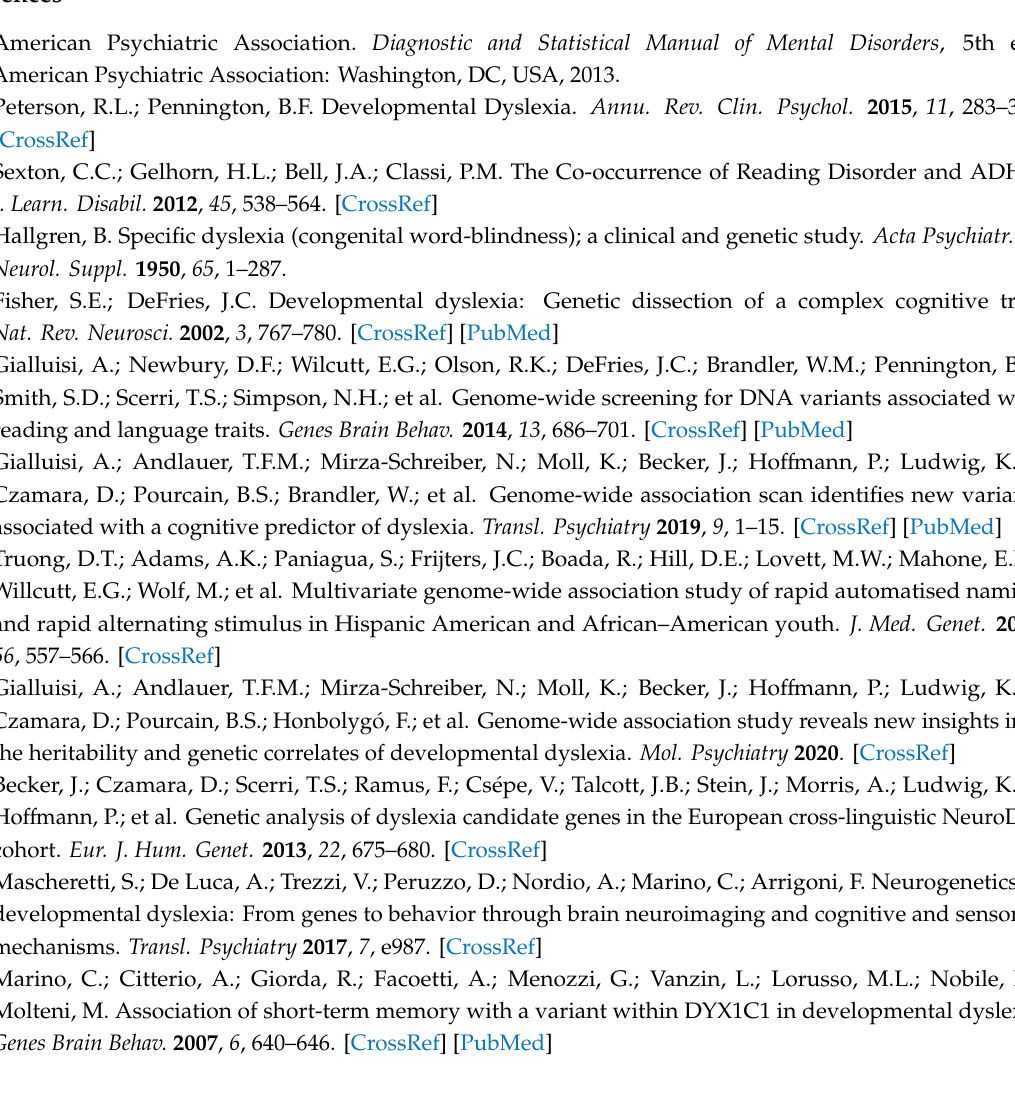
Figure S1: Haploview plot showing pairwise linkage disequilibrium for each gene based on genotypes of unrelated subjects (i.e., probands with DD and typical readers), Table S1: Descriptive statistics of the demographic, neuropsychological and cognitive measures, Table S2: Correlation among the cognitive EPs, age and reading in the total sample ( n =